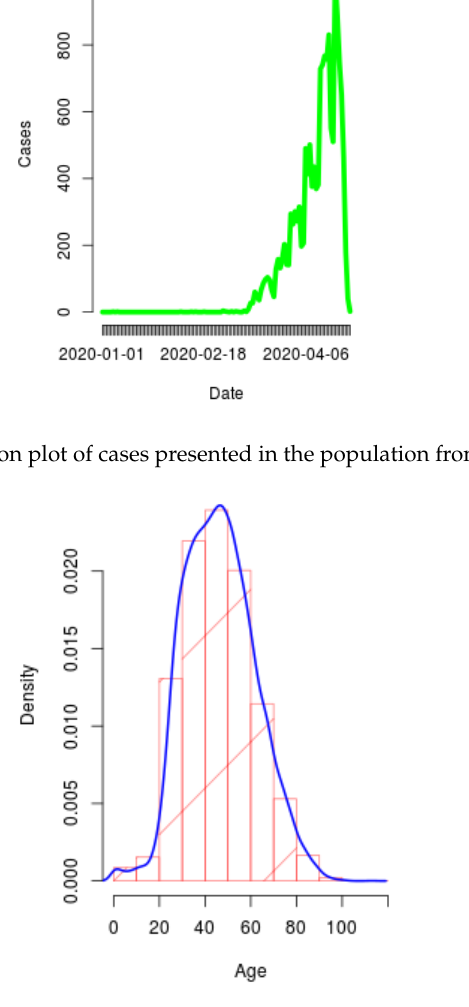
Figure 7. Density plot of the population from all the territory with positive SARS-CoV-2.